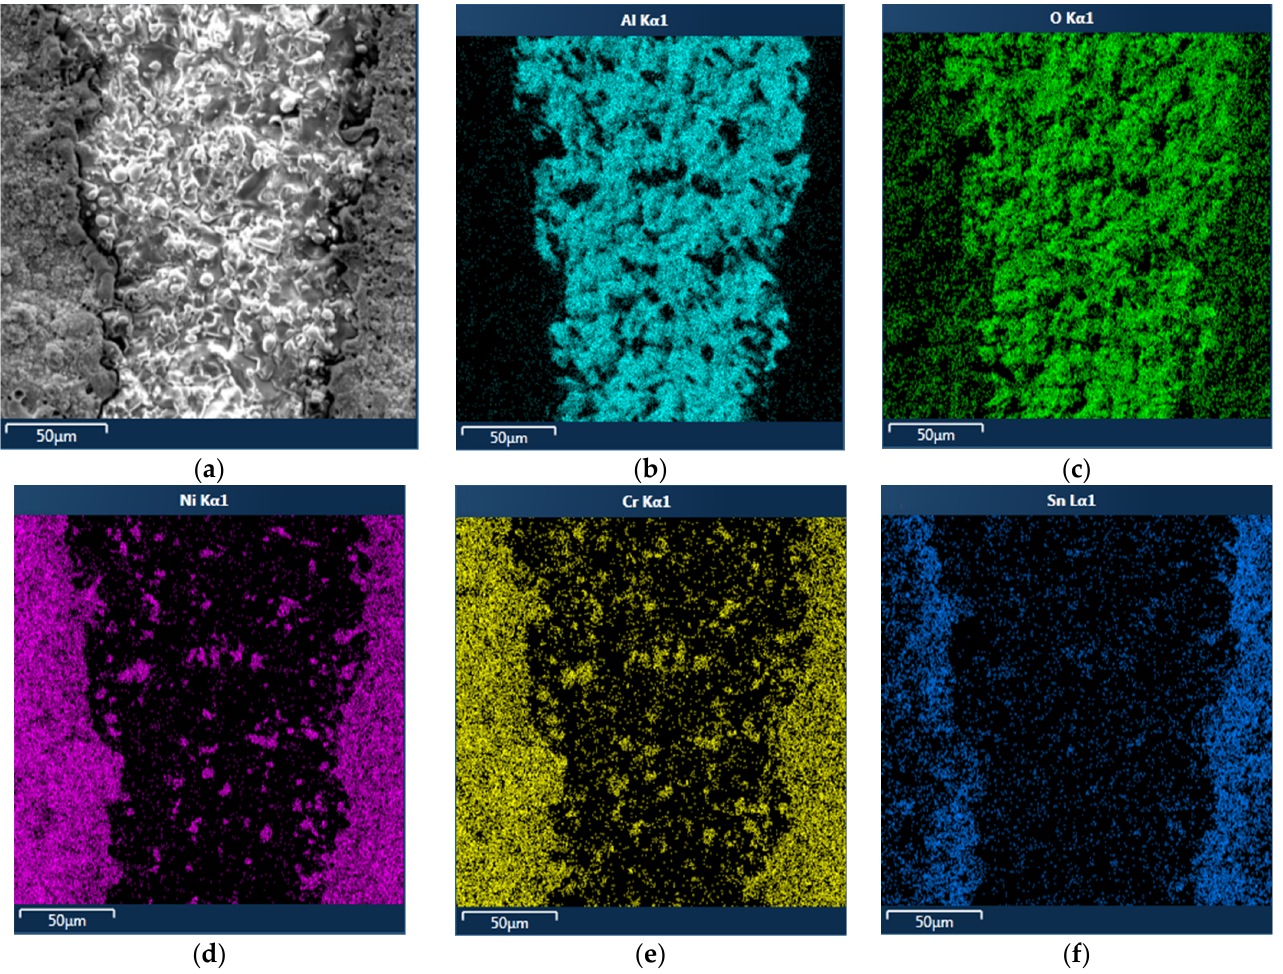
Figure 7. SEM-image of the machined kerf of the coated Al 2 O 3 sample, 10,000× ( a ), chemical mapping of the observed area by elements, aluminum ( b ), oxygen ( c ), nickel ( d ), chrome ( e ), tin ( f ). Table 10. Chemical analysis of machined sample at the machined kerf.